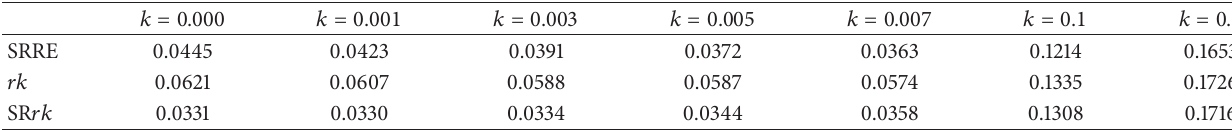
Table 2: Estimated MSE values of 𝑟𝑘 , SRRE, and SR 𝑟𝑘 .